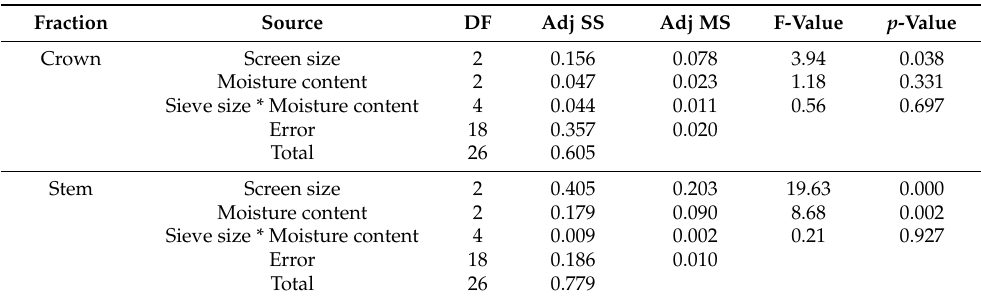
Table 1. ANOVA effects of screen size and moisture content on the compressed density of crown and stem fractions of the briquette ( p < 0.05).